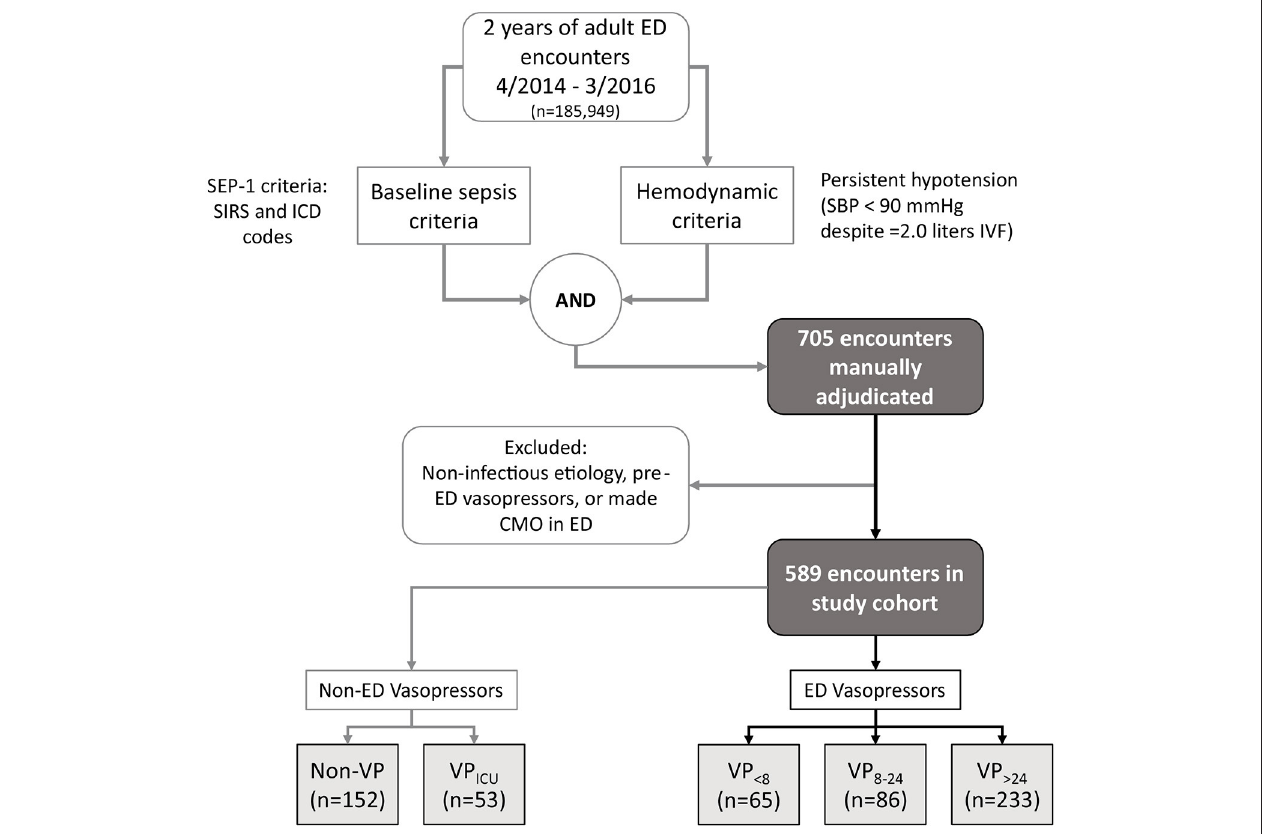
FIGURE 2 | All adult ED patient encounters treated between April 2014 and March 2016 were considered for inclusion in our study. Chart review was performed on those meeting baseline sepsis and hemodynamic criteria, with subsequent exclusion of any patient i) without a likely or possible infectious etiology for ED organ dysfunction, ii) any patient managed with vasopressors in the 12 h before presenting, and iii) any patient made CMO in the ED. The study cohort was split into five mutually exclusive outcome subgroups (see text for definitions). ED, emergency department; CMO, comfort measures only; ICD, international classification of disease; IVF, intravenous fluid; SIRS, systemic inflammatory response syndrome; SBP, systolic blood